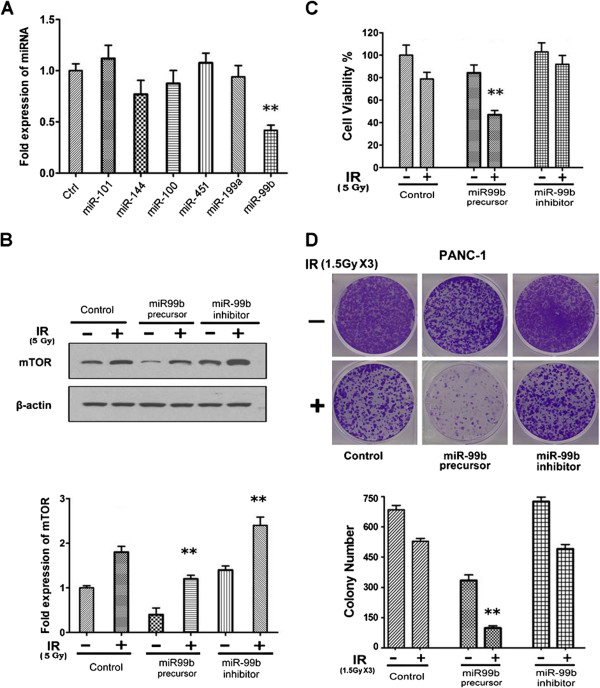
Radiation down-regulates miR-99b which targets mTOR in pancreatic cancer cells. (A) miR-101, miR-144, miR-100, miR-451, miR-199a and miR-99b were tested by real-time PCR before and after radiotherapy (5 Gy), **, P < 0.01 vs. control. (B) miR-99b precursor or miR-99b inhibitor was transfected into PANC-1 cells, followed by radiation at 5 Gy, and mTOR expression was analyzed by Western blot using an mTOR antibody. Western blot bands of mTOR were further quantified by the ImageJ software for calculating the expression of mTOR before and after miR-99b precursor/inhibitor transfection, **, P < 0.01 vs. control with IR. (C) PANC-1 cells were treated with radiotherapy (5 Gy) before and after miR99b precursor/inhibitor transfection for 48 h. Cell viability (%) was analyzed by SRB assay. Error bars represent as mean ± SD, **, P < 0.01 vs. control with IR or miR-99b inhibitor with IR. (D) PANC-1 cells were untreated or treated with radiation (1.5 Gy × 3) before and after miR-99b precursor/inhibitor transfection for 10 days and cell viability was analyzed by colony formation assay. The experiment was repeated three times and the number of colonies was represented as mean ± SD. **, P < 0.01 vs. control with IR or miR-99b inhibitor with IR.